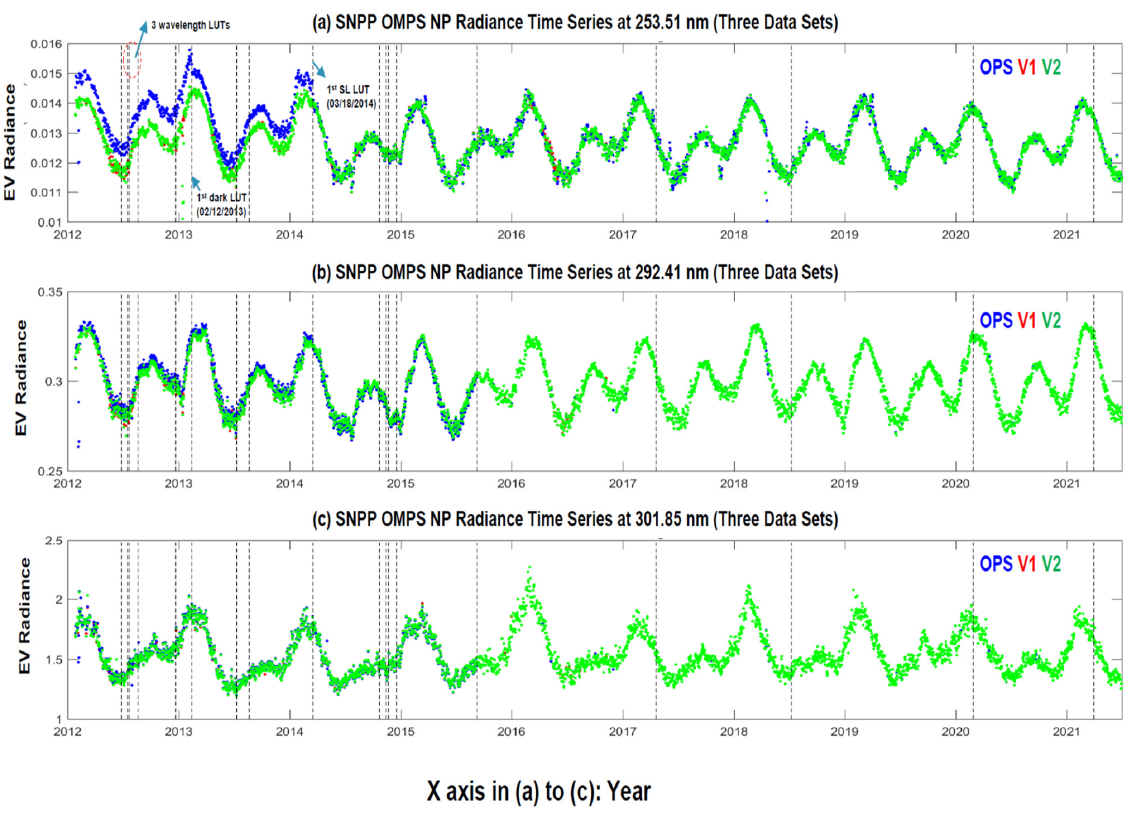
Figure 6. Time series of long–term SNPP OMPS NP averaged radiance at three wavelengths (253.51 nm, 292.41 nm, and 301.85 nm) over the tropic areas (20°N~20°S) among three data sets. Here, the three data sets consist of operational (OPS) (blue color), the 𝑣 1 reprocessed (red color), and 𝑣 2 reprocessed (green color). The data cover the period from 25 January 2012 through 30 June 2021, except for the v01 data set which covers the period until 8 March 2017; a series of straight dash lines in the figure represent the implementation date with respect to a specific calibration table. In ( a ), the updates of three types of the LUTs are highlighted: 3 wavelength LUTs in middle 2012, 1st dark LUT in February 2012, and 1st SL LUT in March 2014, referring to Appendix A; ( a ) 253.51 nm, ( b ) 292.41 nm, ( c ) 301.85 nm.